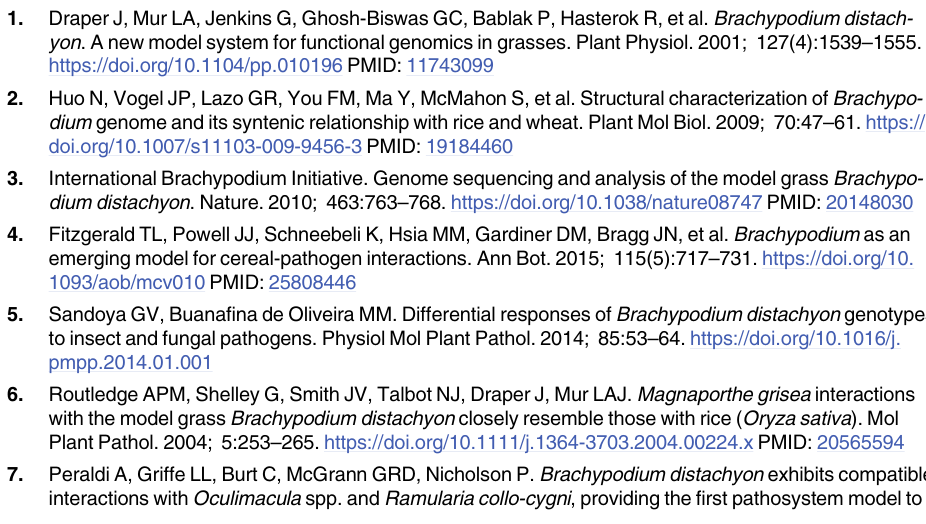
S4 Table. ANOVA statistical evaluation for damage to leaves of wheat by pathogen Fusar- ium culmorum when the main experimental factor is previous inoculation with the endo- phytic fungus Microdochium bolleyi